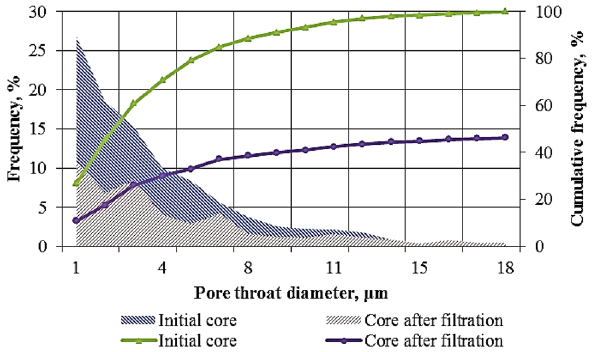
Fig. 10 Pore throat diameter distribution before and after